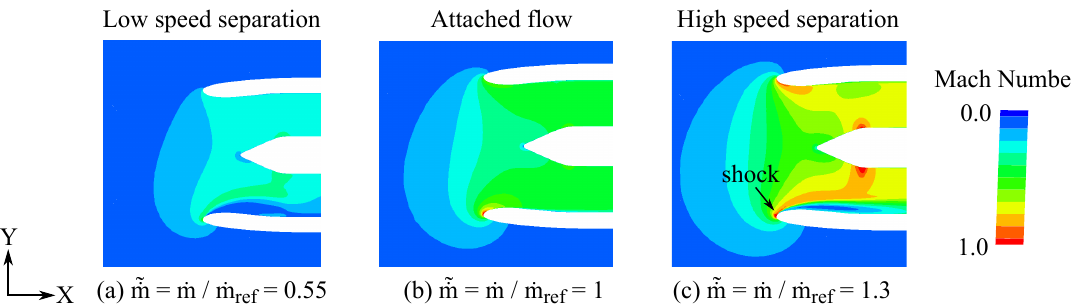
Figure 3. Mach number contours on Z = 0 plane for increasing engine mass flow